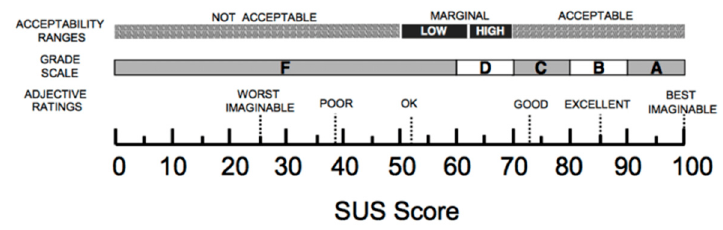
Figure 6. Results of usability measurement using SUS.